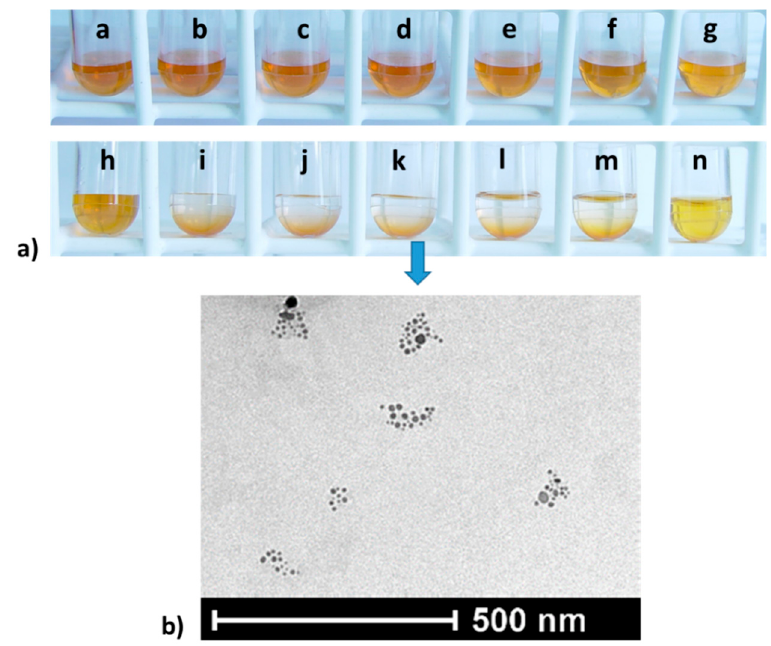
Figure 10. ( a ) Color changes of the AgNPs + ab + FLCs solutions, with FLCs concentrations from 0 to 22 mg/L, which are represented by the letters a–n. ( b ) TEM image of silver nanoparticle aggregates (k). Changes in the absorbance of antibody-coated nanoparticles (10 nM), with the maximum LSPR (395 nm) and increasing FLCs concentrations. The biggest changes were observed at a FLCs concentration of 10 mg/L (500 nM).